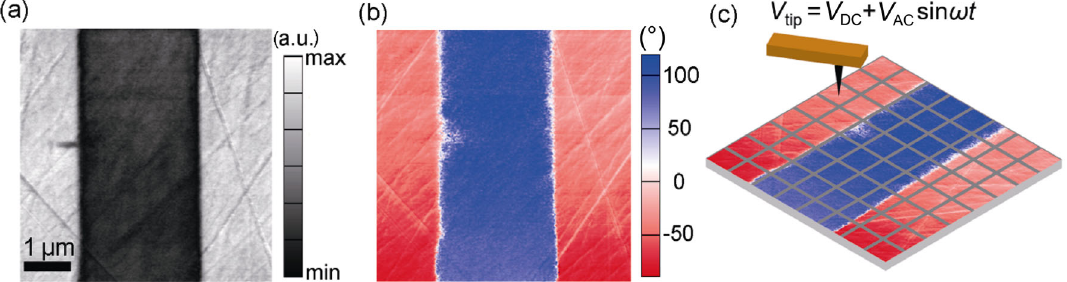
Fig. 1 PFM imaging and a schematic of tip movement during SS-PFM mapping. (a) Piezoresponse amplitude and (b) phase contrast images of the KNN single crystals. (c) In SS-PFM, local hysteresis loops are collected using a waveform at each point on 25 × 25 mesh. Detailed description of SS-PFM was previously reported by Ref. [20]. The domain wall shown in Fig. 1(b) orients along [001] c